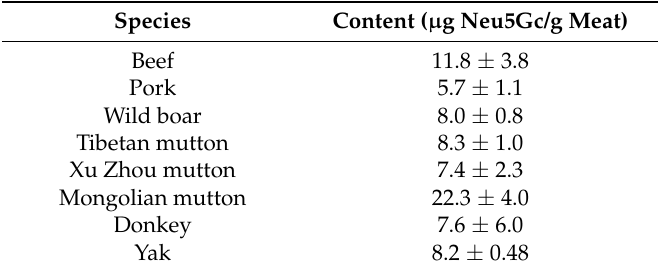
Table 1. Neu5Gc concentrations in meat samples.